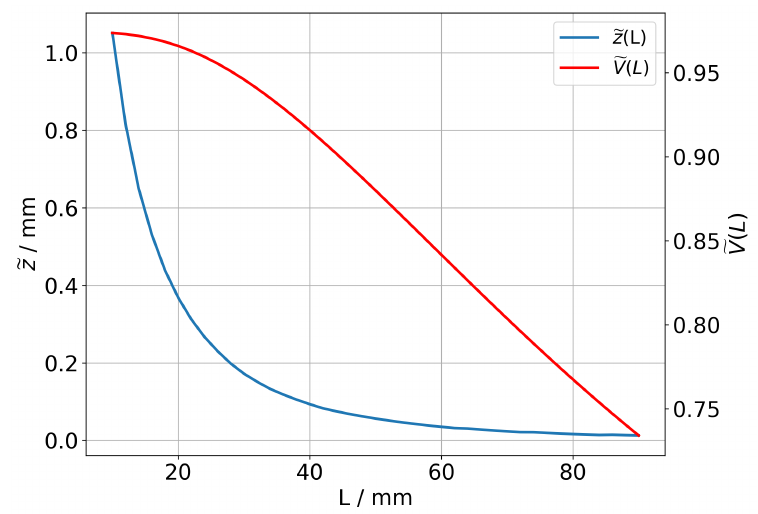
Figure 5. The relative distance of how far the separatrix elongates axially ̃ z = ( z sep − L / 2 )/ L and the ratio ̃ V of the active volume V active to the total volume V total as a function of L are plotted. Both affect the performance of a HEMP